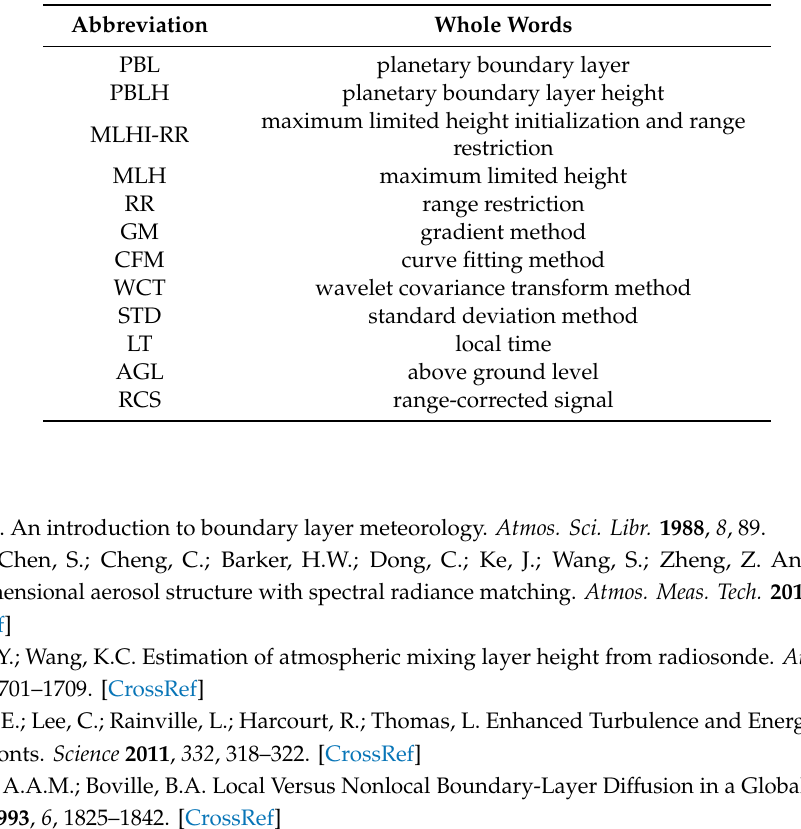
Table A1 is the abbreviation index of proper nouns used in this paper. Table A1. Abbreviation